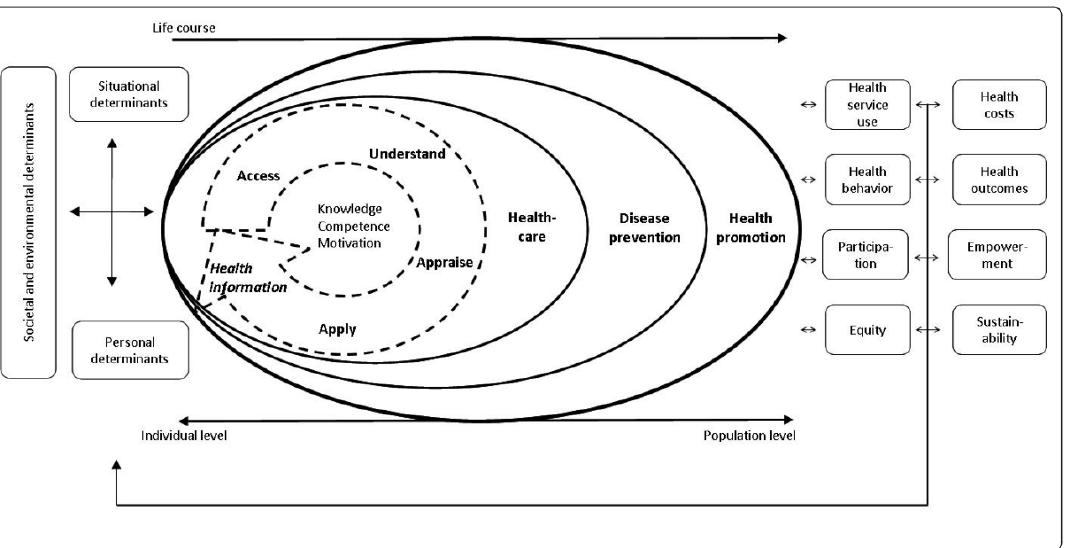
Figure 1. Sørensen et al.’s integrated model of health literacy (2012; courtesy of Dr. Sørensen and her colleagues under CC by 2.0 license)